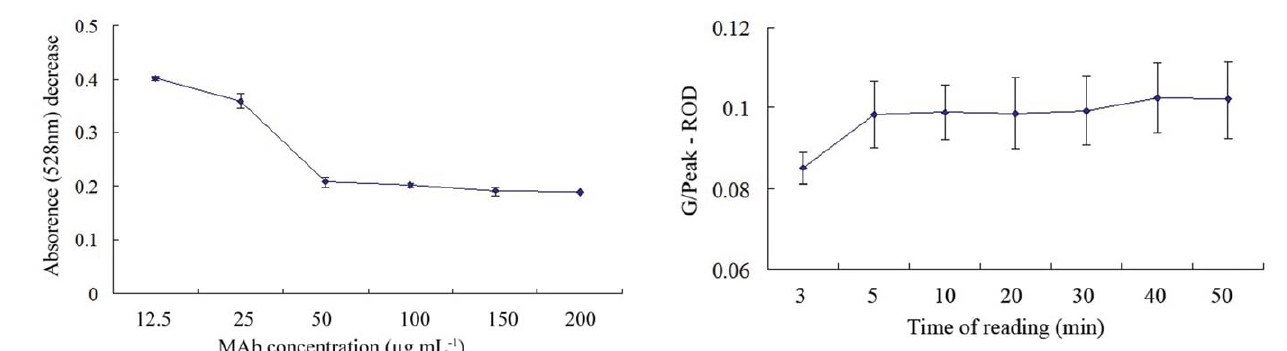
Figure 3. Flocculation curves. Each point on the y axis represents the mean D-value of absorbance (528 nm) in two stages (for details, see materials and methods), and the x axis values are the concentration of the mAb (n=3).